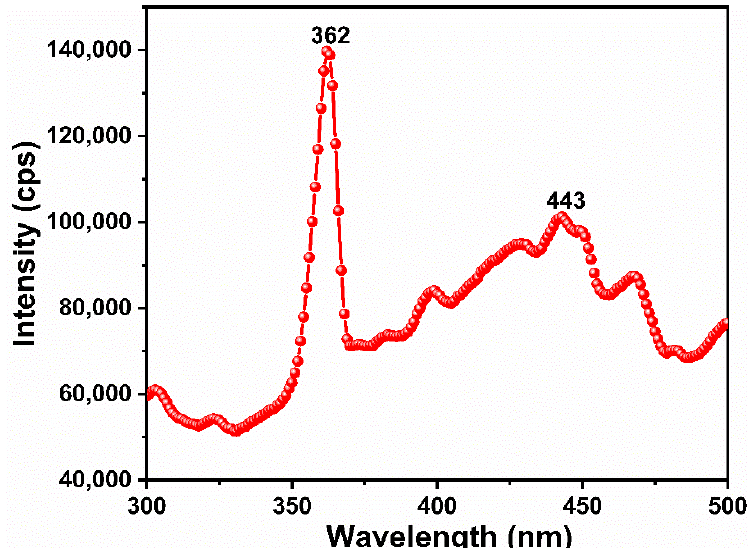
Figure 7. PL spectrum of MgO NBs.